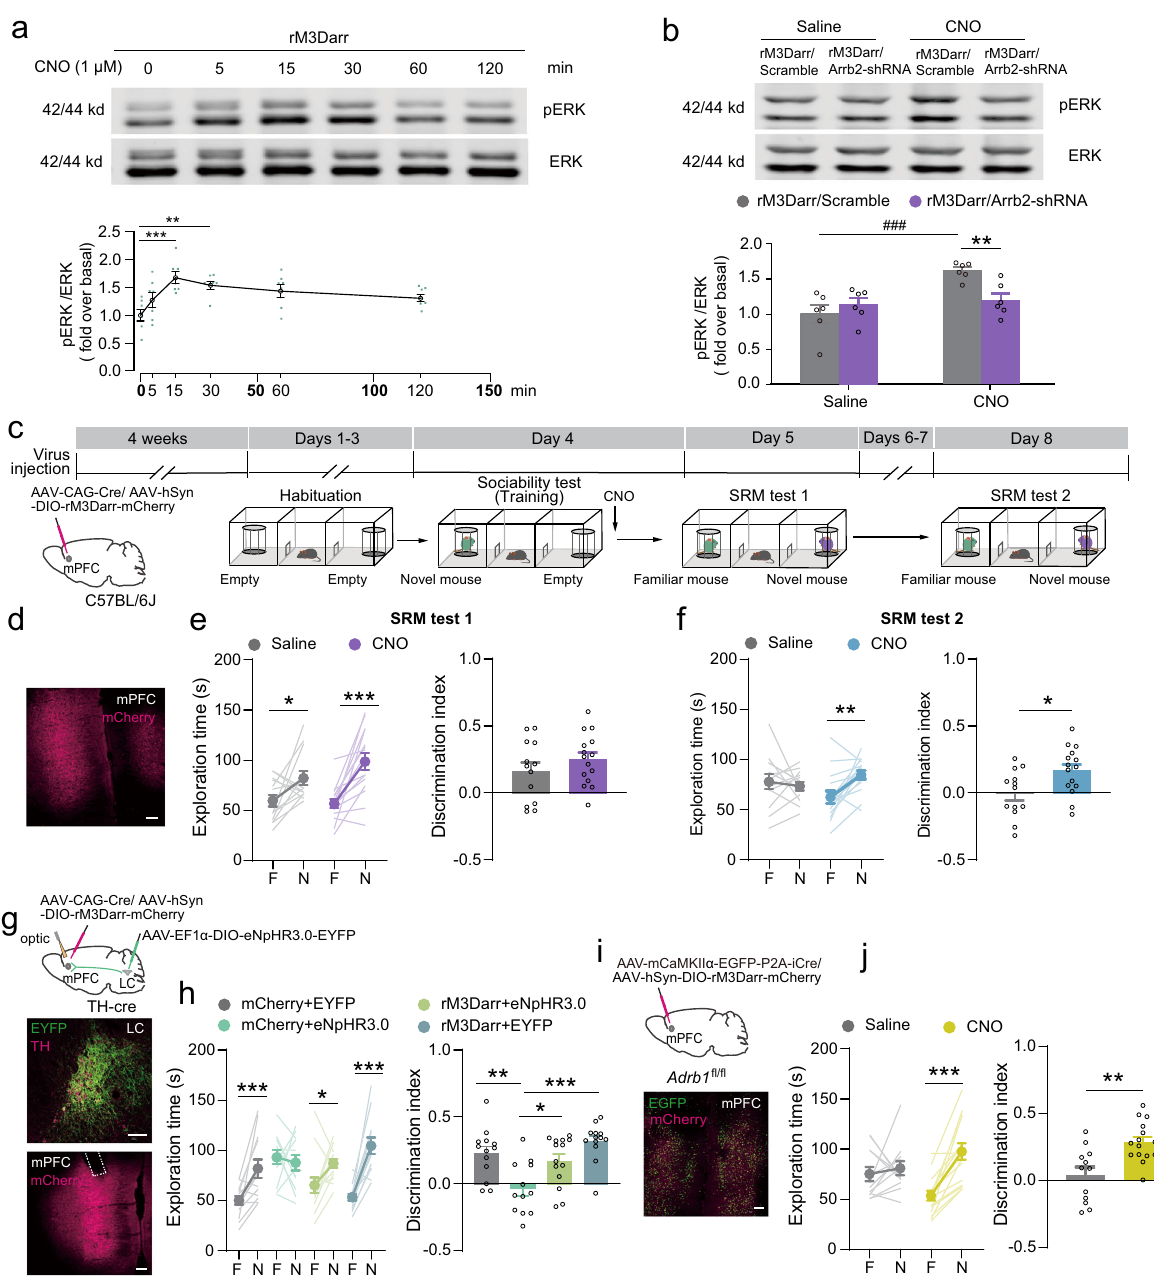
Fig. 5 Activation of β -arrestin biased signaling in the mPFC rescued impairment of SRM consolidation by LC-mPFC NE projection inhibition or β -AR knockout. a CNO (1 μ M) signi fi cantly increased the pERK levels 15 – 30 min after treatment in N2a cells transfected with rM3Darr [ n = 7 for each group, 15 min: F (5, 36) = 5.261, p < 0.001, one-way ANOVA]. b Arrb2 knockdown inhibited ERK activation by CNO treatment (1 μ M) in N2a cells transfected with rM3Darr at 15 min [n = 6 for each group, F shRNA × treatment (1, 20) = 8.207, p = 0.010, two-way ANOVA]. c Experimental scheme. AAV 9 -hSyn-DIO- rM3Darr-mCherry and AAV 9 -CAG-Cre were injected in the mPFC of C57BL/6 J mice. Four weeks later, SRM task was performed. The mice were injected with CNO (1 mg/kg, i.p.) after training and SRM tests were performed 1 day and 4 days later. d Representative image of rM3Darr-mCherry expression in the mPFC. e , f Statistical graphs of exploration time for the familiar (F) and novel (N) mice and discrimination scores [Saline, n = 13; CNO, n = 15. e Left: F = 2.29, p = 0.142, two-way RM ANOVA; Right: t (26) = − 1.121, p = 0.273, two-tailed Student ’ s t test. f Left: F mouse × treatment (1, 26) = 7.024, p = 0.014, two-way RM ANOVA; Right: t (26) = − 2.579, p = 0.016, two-tailed Student ’ s t test]. g Virus injection and representative images of eNpHR3.0-EYFP expression in the LC, rM3Darr-mCherry expression and optical fi ber tip in the mPFC. AAV 9 -EF1 α -DIO-eNpHR3.0-EYFP was injected in the LC, AAV 9 -hSyn-DIO-rM3Darr-mCherry and AAV 9 -CAG-Cre were injected into the mPFC of TH-Cre mice. Optical fi bers were implanted above the mPFC. h Statistical graphs of exploration time for the familiar (F) and novel (N) mice and discrimination scores [EYFP/mCherry, n = 13; EYFP/rM3Darr, n = 12; eNpHR3.0/rM3Darr, n = 14; eNpHR3.0/mCherry, n = 13. Left: F mouse × virus (3, 48) = 7.135, p < 0.001, two-way RM ANOVA, Right: F (3, 48) = 8.697, p < 0.001, one-way ANOVA]. i Virus injection and representative image of rM3Darr-mCherry and Cre-EGFP expression in the mPFC. j Statistical graphs of exploration time and discrimination scores [Saline, n = 12; CNO, n = 15. Left: F mous × treatment (1, 25) = 9.238, p = 0.005, two-way RM ANOVA; Right: t (25) = − 3.638, p = 0.001, two-tailed Student ’ s t test]. * p < 0.05, ** p < 0.01, *** p < 0.001 and ### p < 0.001 vs indicated group. Scale bar: 100 μ